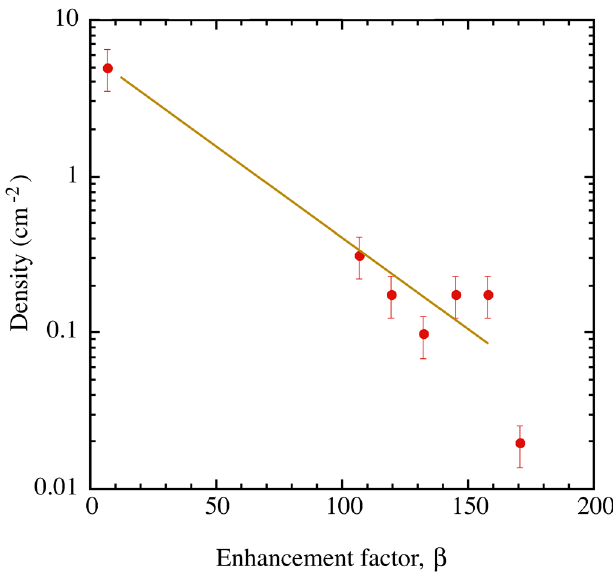
7. (Color) The spectrum of secondary emitters produced in breakdown events in this cavity.